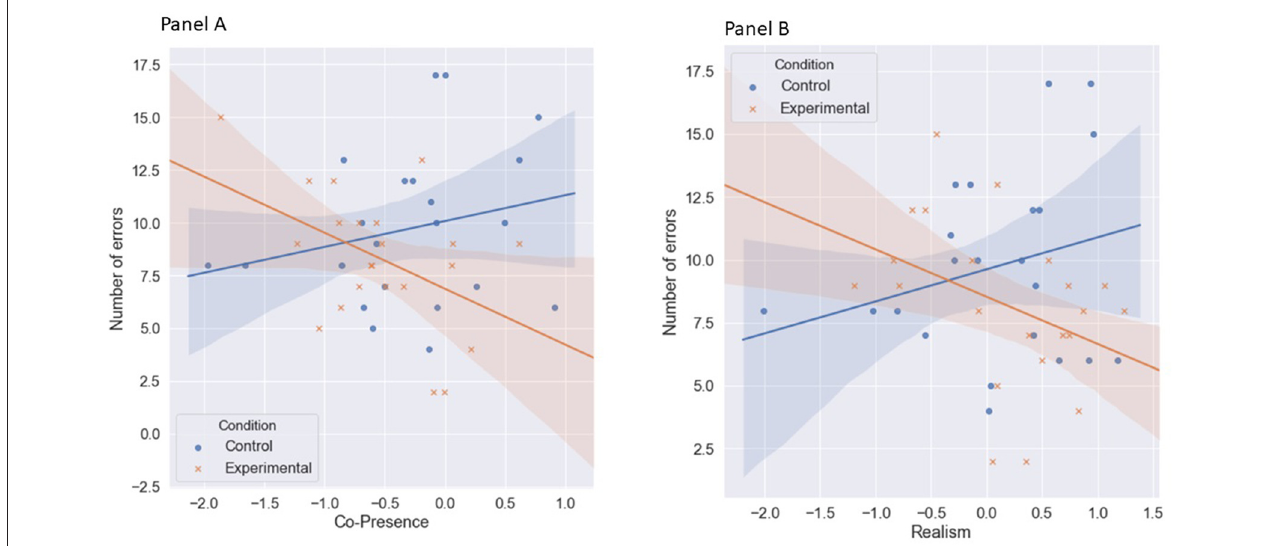
FIGURE 5 | Graphical representation of the interaction—the number of errors committed in VR simulation depending on the interaction of the presence of audience and the subjectively assessed VR characteristics: co-presence (A) and sense of realism (B) .